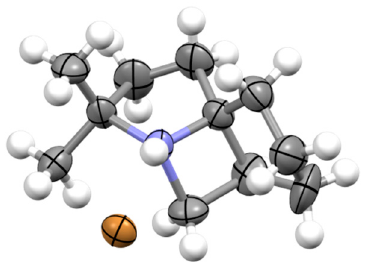
Figure 1. The structure of 3 × HBr according to X-ray analysis.